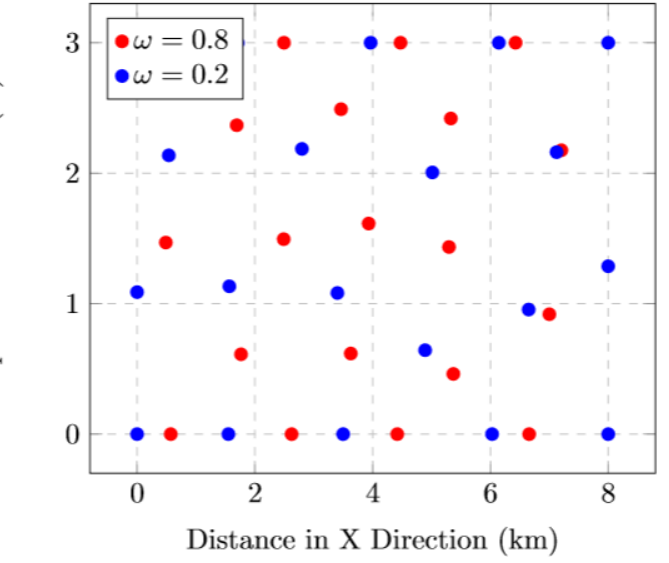
Figure A6. Final positions for an alternative environment, namely with ω = 0.8 and ω = 0.2 and 20